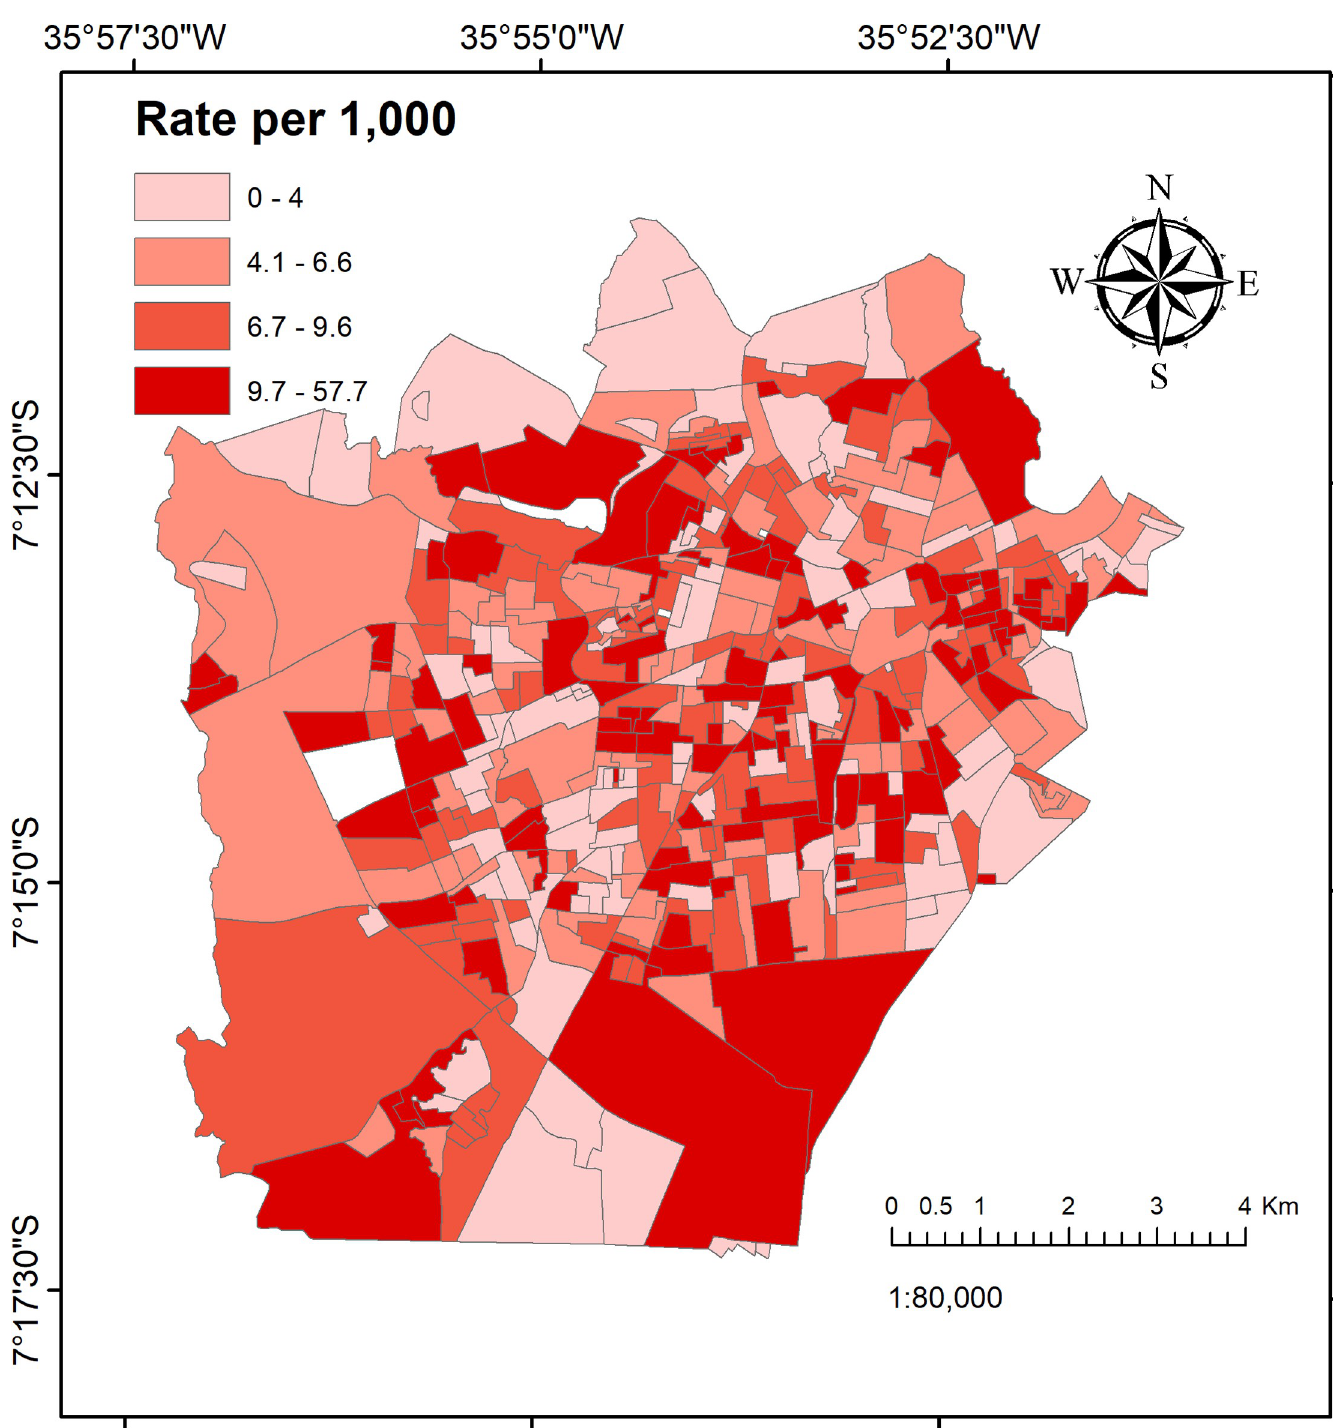
Fig 6. Rate of injured victims per 1,000 population, using a census tract map categorised by quartile.